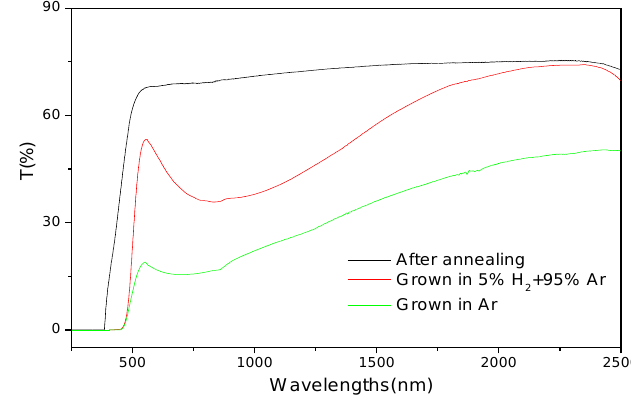
Figure 3. Transmittance of CeAlO 3 crystals annealed and grown in different growth atmospheres.